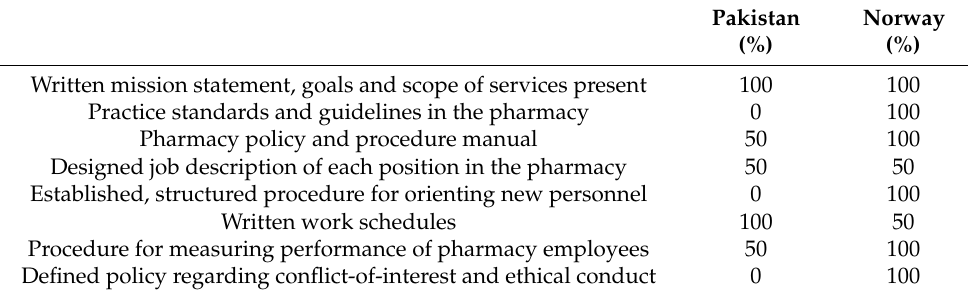
Table 1. Pharmacists’ assessments on practice management.